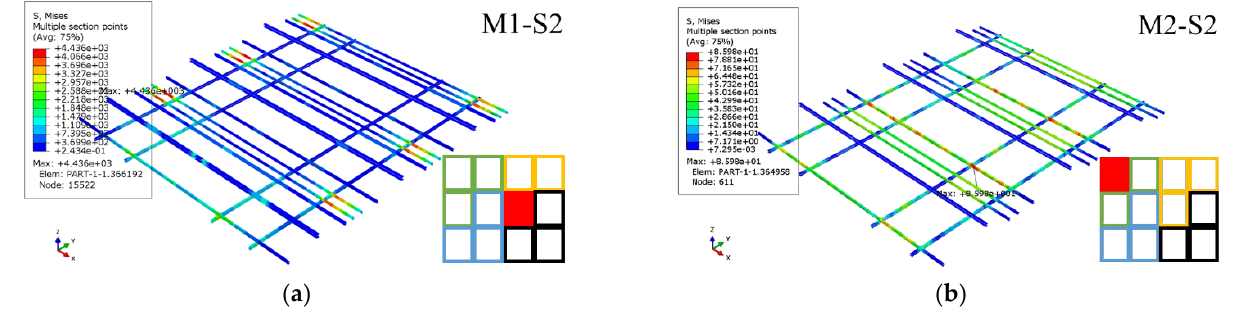
Figure 10. Maximum von Mises stresses in FRP frames: ( a ) M1-S2 (uneven mass and wave incident angle of 45 ◦ ); ( b ) M2-S2 (even mass and wave incident angle of 45 ◦ ).